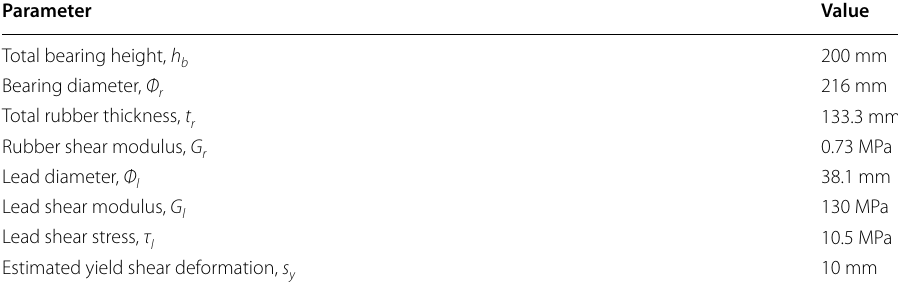
Table 1 Geometric and mechanical properties of the LRB Parameter Total bearing height, h